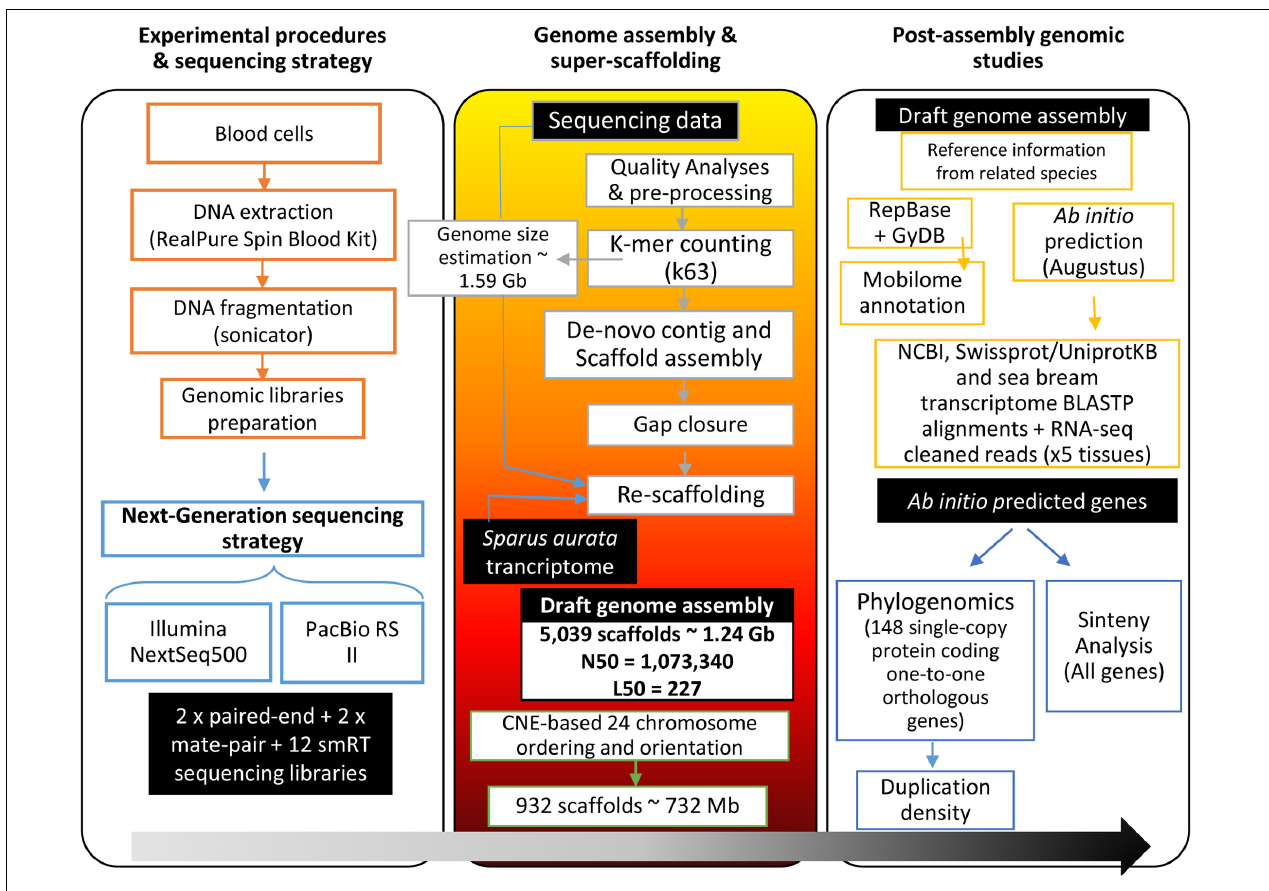
FIGURE 1 | Workflow of the gilthead sea bream genome assembly project. Black boxes with white text indicate generated genomic resources, according to the following steps: experimental procedures and sequencing, genome assembly and super-scaffolding, and post-assembly analyses over the genome draft ( ab initio gene prediction, synteny analysis,